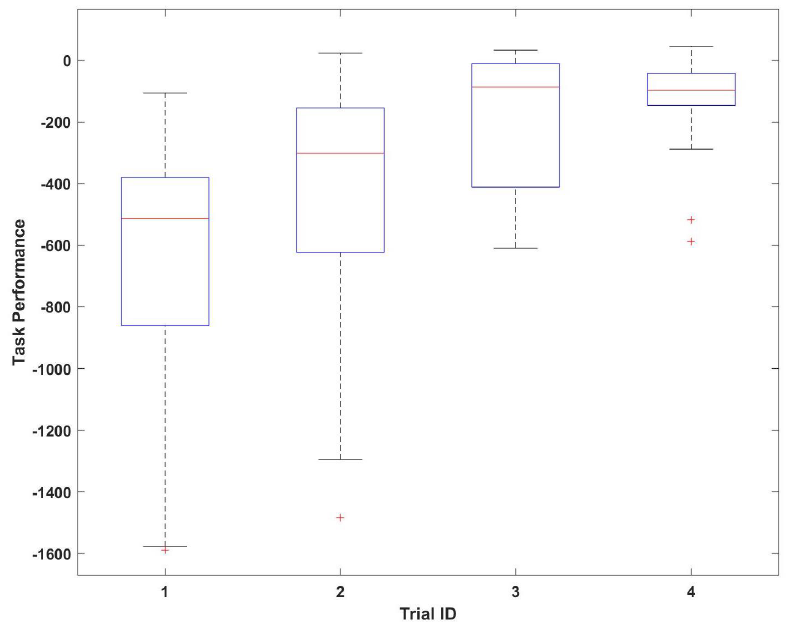
Figure 4. Variation of task performance throughout the trials.